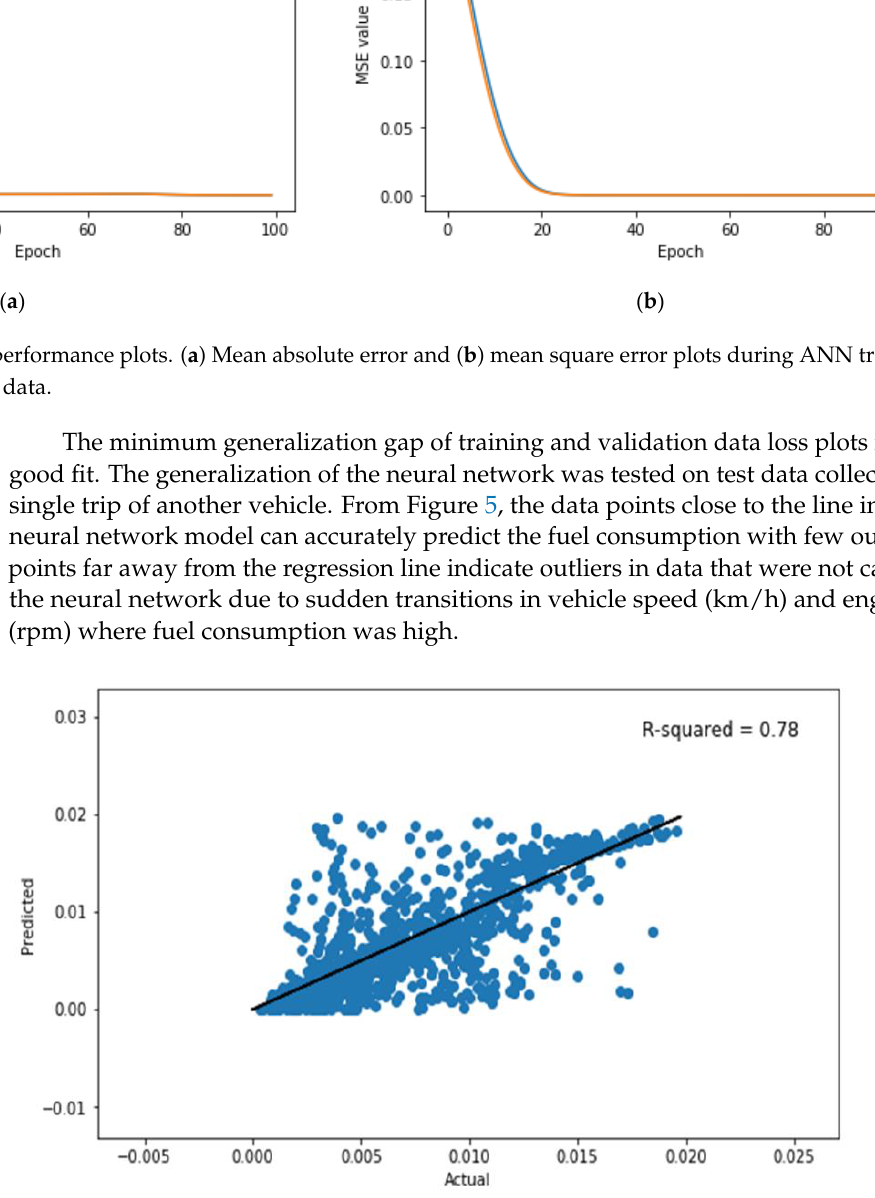
Table 2. Comparison of performance on test